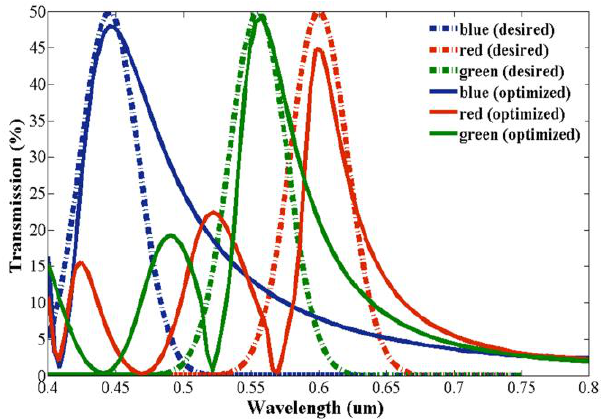
Figure 4. Transmission characteristics of the designed PCFs compared with the desired Gaussian